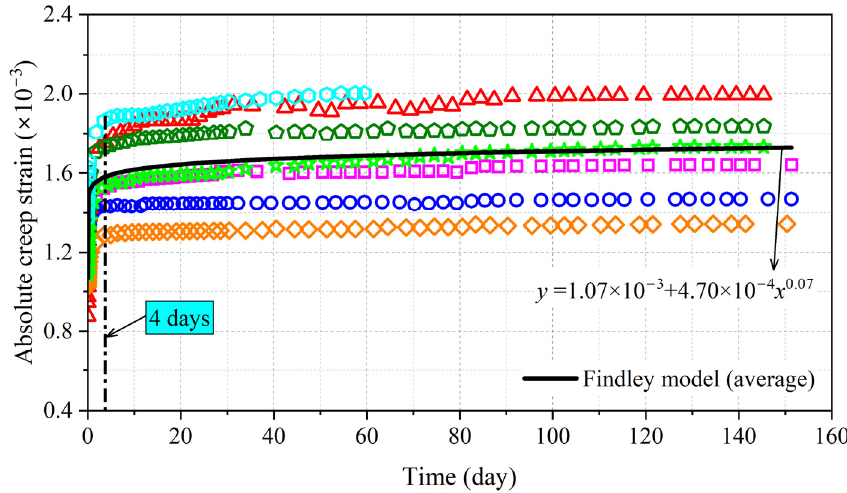
Figure 7. Absolute creep strain of BS perpendicular to grain.